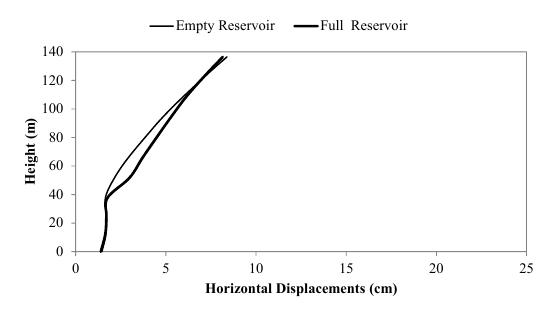
a) The maximum horizontal displacements in downstream direction according to linear analysis.